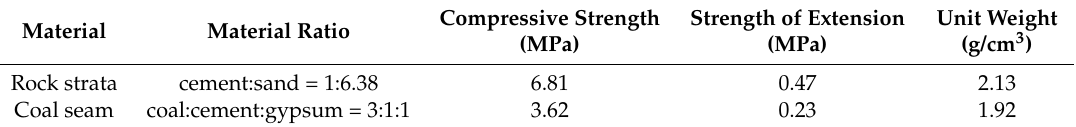
Figure 6. Photograph of 7 cm cubes of coal seam simulation material. The numbers on the cubes represent the different coal: cement; gypsum ratios used to manufacture the test cubes. Table 1. Basic mechanical parameters of the samples used in the HF tests.